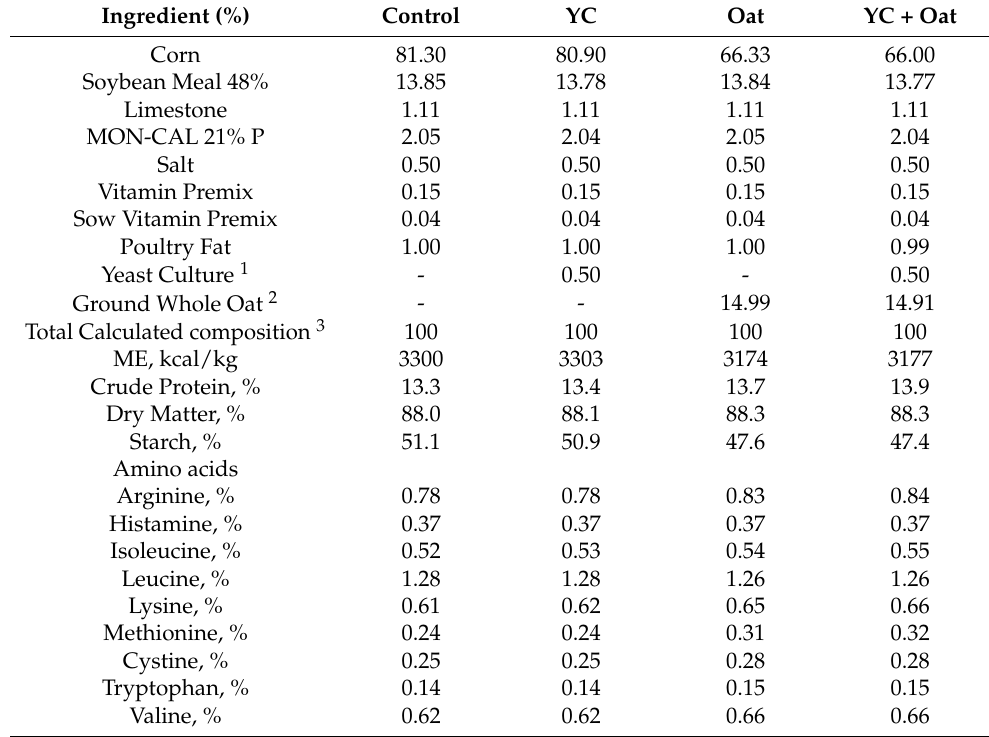
Table 1. Ingredient composition of sow gestation